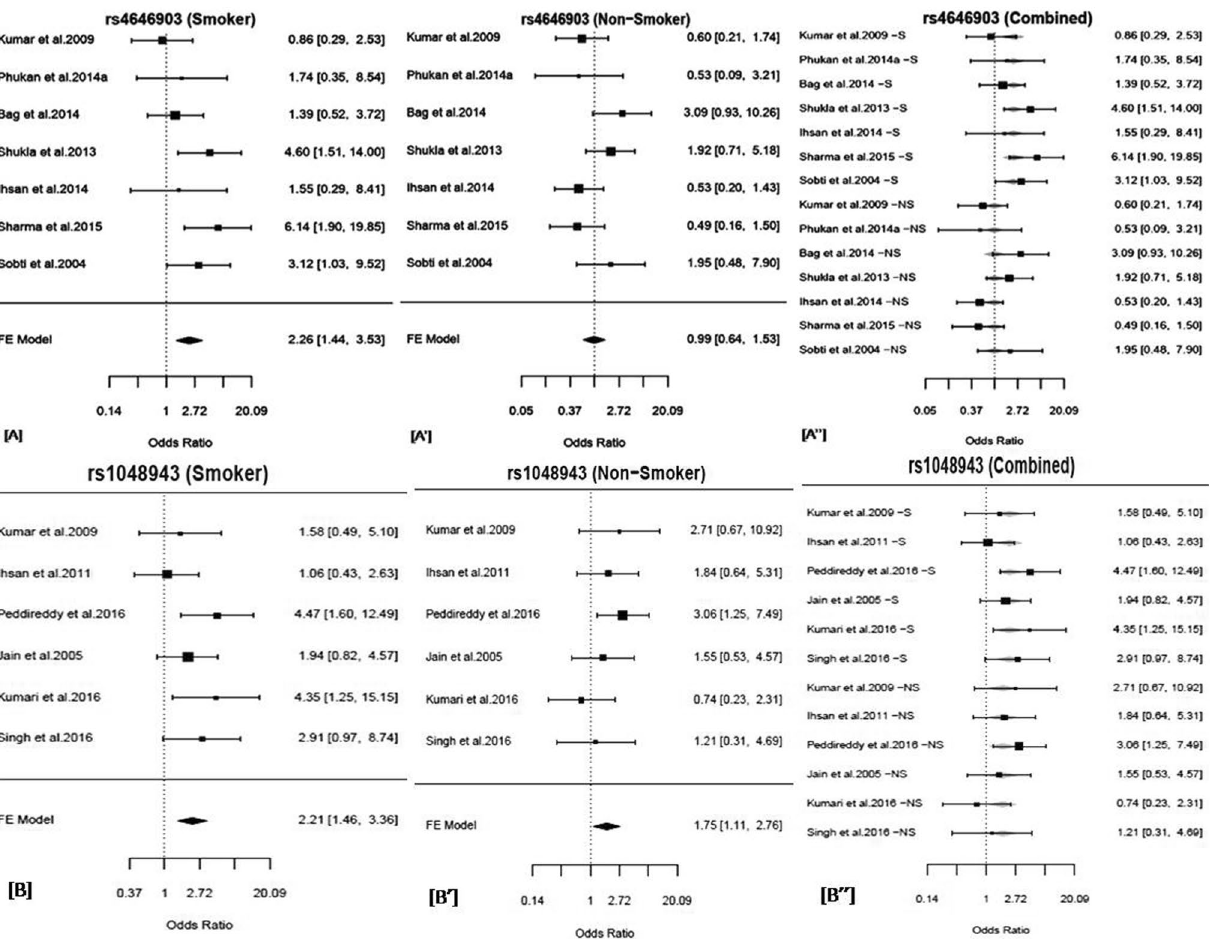
Figure 3. Forest plot depicting the odds ratios (ORs), and 95% CI of, rs4646903/ CYP1A1 for its association with lung cancer in a dominant model in the Indian subcontinent among ( A ) Smokers, ( A’ ) Non-Smokers and ( A’’ ) Combine forest plot of rs4646903/ CYP1A1 for its association with lung cancer stratified by smoking status in a dominant model in the Indian subcontinent, Forest plot depicting the odds ratios (ORs), and 95% CI of, rs1048943/ CYP1A1 for its association with lung cancer in a dominant model in the Indian subcontinent among ( B ) Smokers, ( B’ ) Non-Smokers, and ( B’’ ) Combine forest plot of rs1048943/ CYP1A1 for its association with lung cancer stratified by smoking status in a dominant model in the Indian subcontinent. The forest plots of the significant associations were given ( p < 0.05*). The figures were generated in the ‘metafor’ package (http:// www. metaf or- proje ct. org) of R software (https:// cran.r- proje ct. org/).